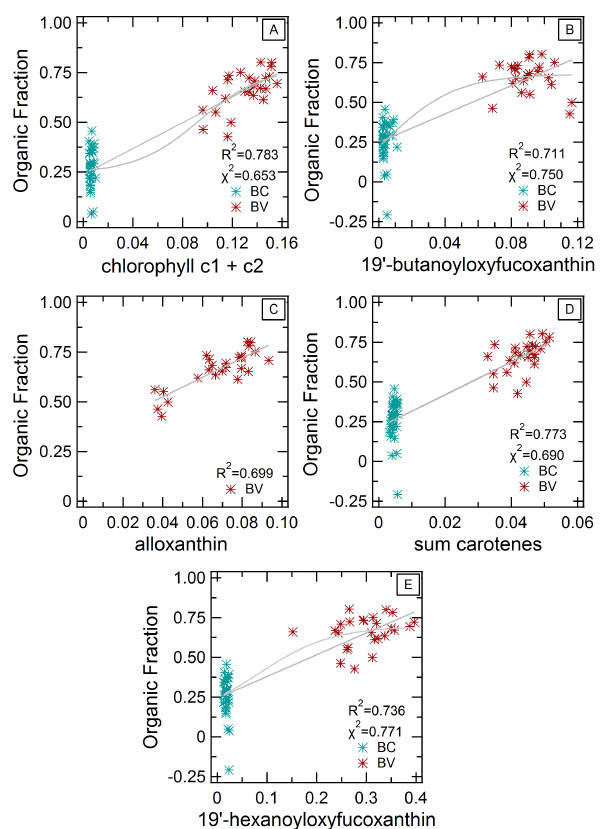
Figure 8. Organic fraction calculated from kappa ( κ org = 0.006 and κ inorg = 1.25) at SS = 0.39% vs. chlorophyll c1 + c2 (a) , 19 (cid:48) - butanoyloxyfucoxanthin (b) , alloxanthin (c) , sum carotenes (d) and 19 (cid:48) -hexanoyloxyfucoxanthin (e) concentrations (mgm − 3 ) for all three mesocosms during both BC and BV. Linear fits with R 2 val- ues are shown for all figures, and sigmoid fits with χ 2 values are shown for all panels except for (c)